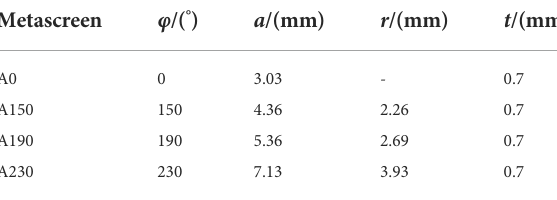
TABLE 1 Structural parameters of four